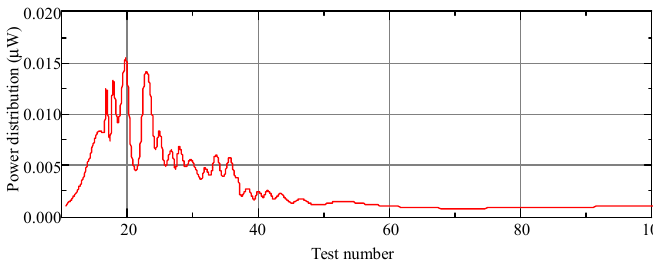
Fig. 9 Power distribution of the received light during the